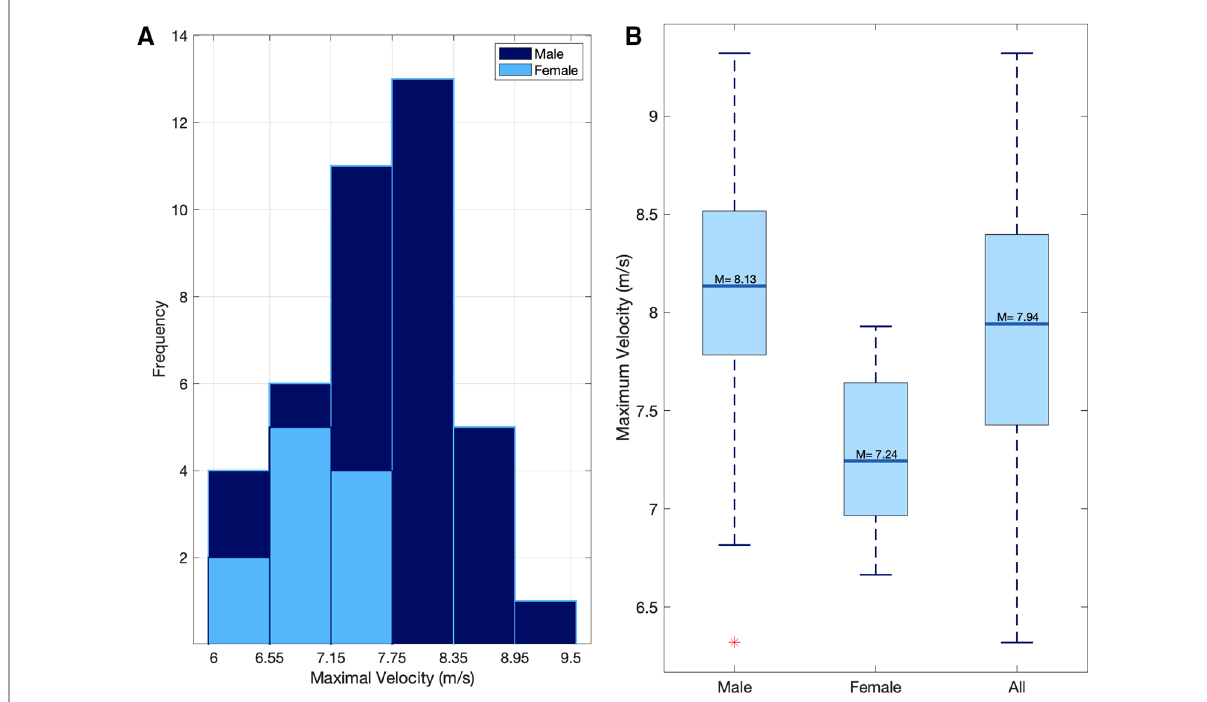
FIGURE 3 ( A ) the distribution of peak sprint velocities for both males and females. ( B ) The mean sprint velocity for Male, female, and all